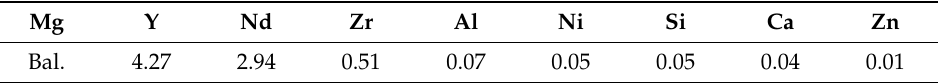
Table 1. Chemical compositions of as-cast Mg-Y-Nd alloy (mass fraction, %).